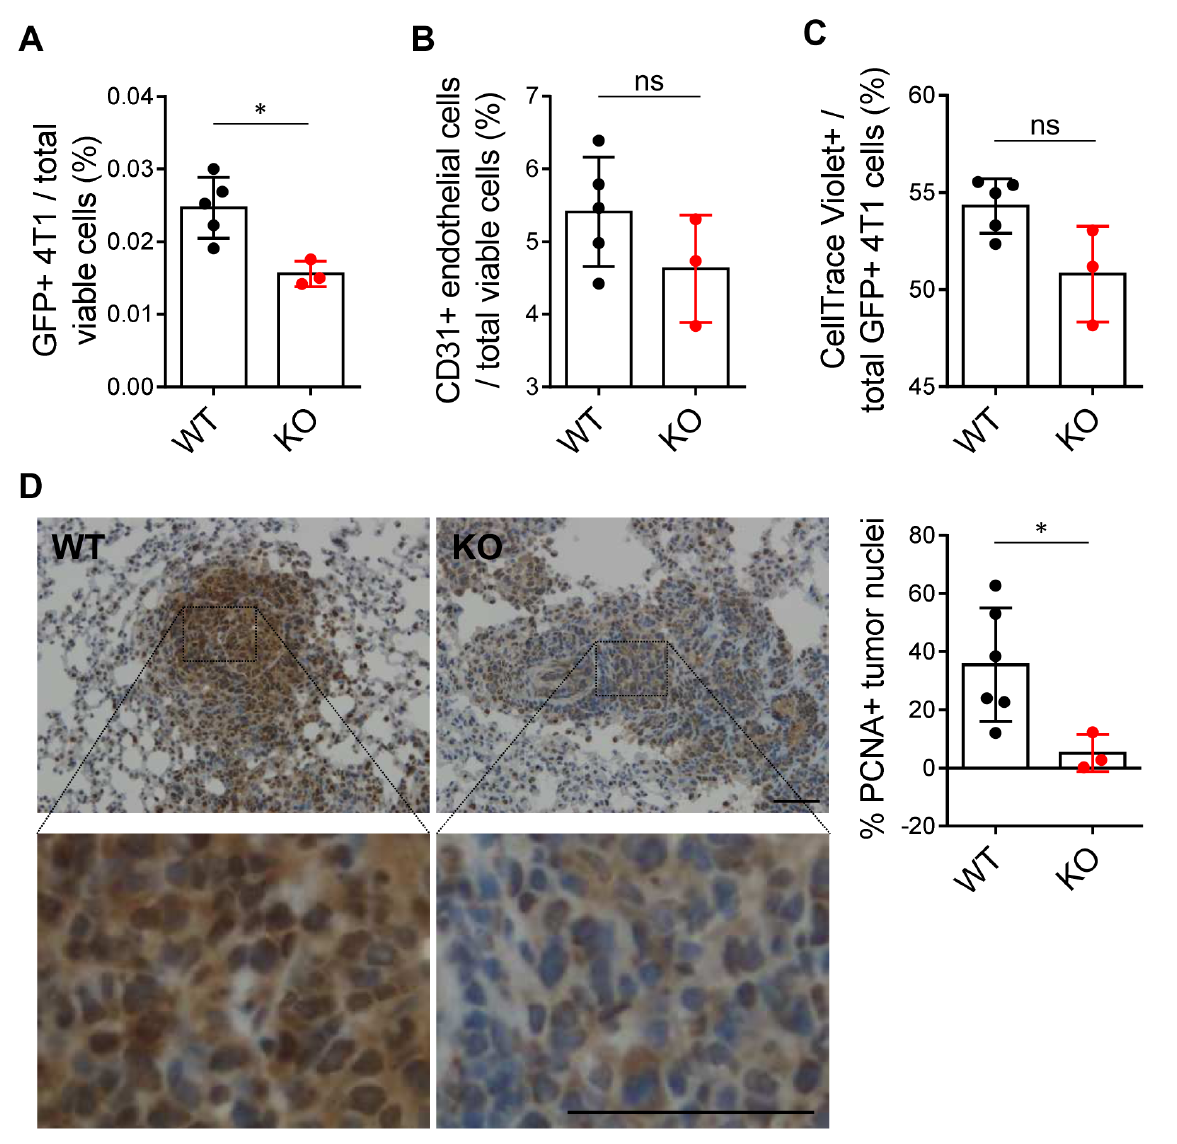
Figure 5. Ephrin-A1-deficient lung microenvironment provides a less favorable metastatic niche. ( A ) Quantification of GFP+ 4T1 cells and ( B ) CD31+ endothelial cells by flow cytometry in perfused lungs harvested from WT and KO littermates 24 hours post-tail vein injection. ( C ) Percentage of GFP+ 4T1 cells in perfused WT and KO lungs that still contained CellTrace Violet dye, indicating reduced proliferation. ( D ) Representative images of PCNA staining on FFPE sections of tumor-bearing lungs from WT and KO littermates 17 days after tail vein injection of 4T1-GFP-luciferase cells. Higher magnification images and blinded quantification of PCNA+ tumor cell nuclei shown. Scale bar: 50 µm. Data shown are averages ± SD with each data point representing an individual mouse ( n =3–6 mice per group). * p <0.05 (unpaired Mann-Whitney U